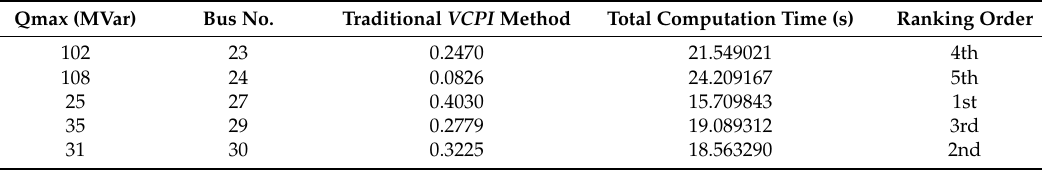
Table 5. Results of the VCPI for the IEEE 30-bus power